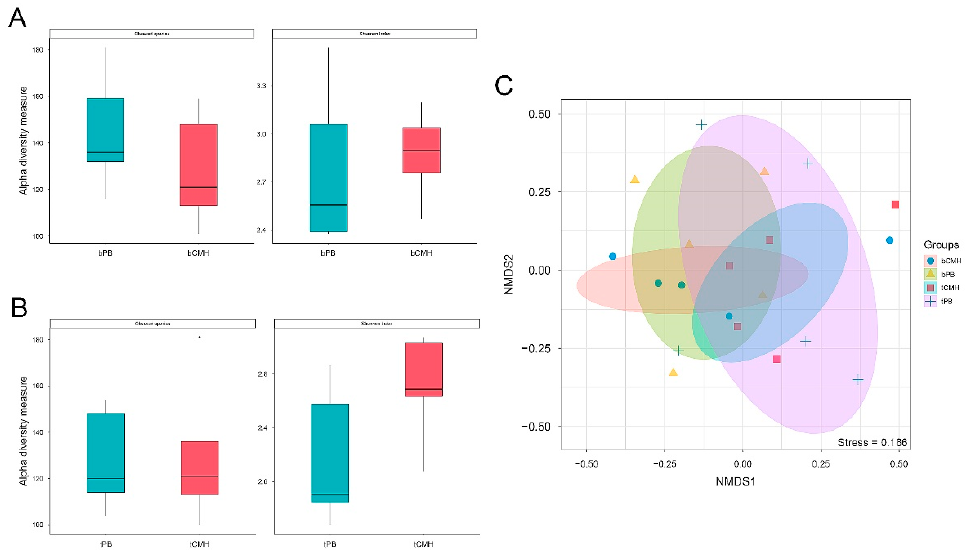
Figure 2. Comparison of microbial diversity across all possible groups. ( A , B ) Boxplots of the alpha- diversity in contexts of observed species and Shannon index of each pairwise group, respectively; ( C ) Beta-diversity plot of non-metric multidimensional scaling (NMDS) ordination in context of Bray–Curtis dissimilarity among each group. Taxonomic diversity was assessed at species level. In addition, bPB, bCMH, tPB, and tCMH represent baseline placebo, baseline CMH, treatment with placebo, and treatment with CMH, respectively.